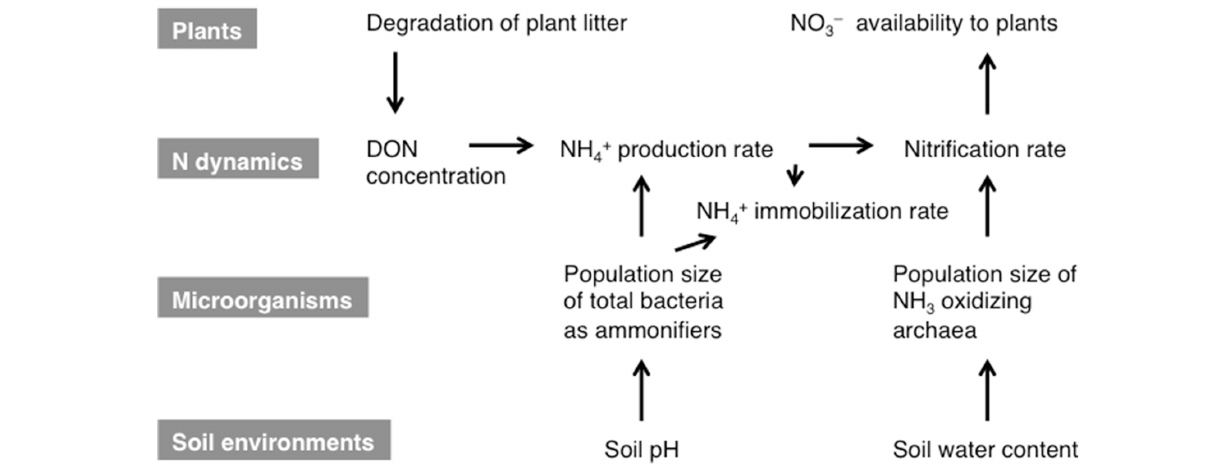
FIGURE 3 | Conceptual diagram showing the regulation of N transformation on the examined slope. The effects of the gradients in the soil environmental properties on the bioavailable N dynamics are mediated via the microbial population dynamics. The relationships among the three categories are influenced by plant litter fall, which affects the plant N availability. The gross NH + 4 production rate is affected by the concentration of